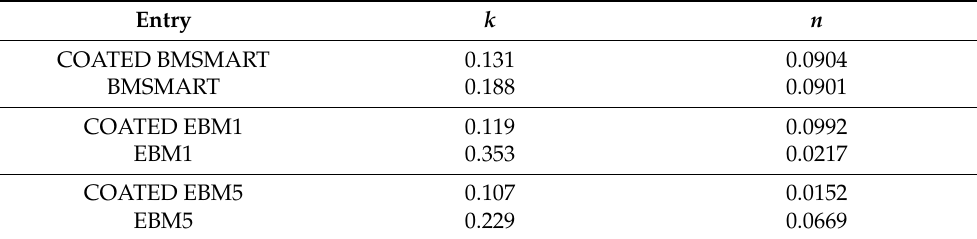
Table 3. k constant and n exponent in the Kormeyer–Peppas equation calculated for the different coated and uncoated